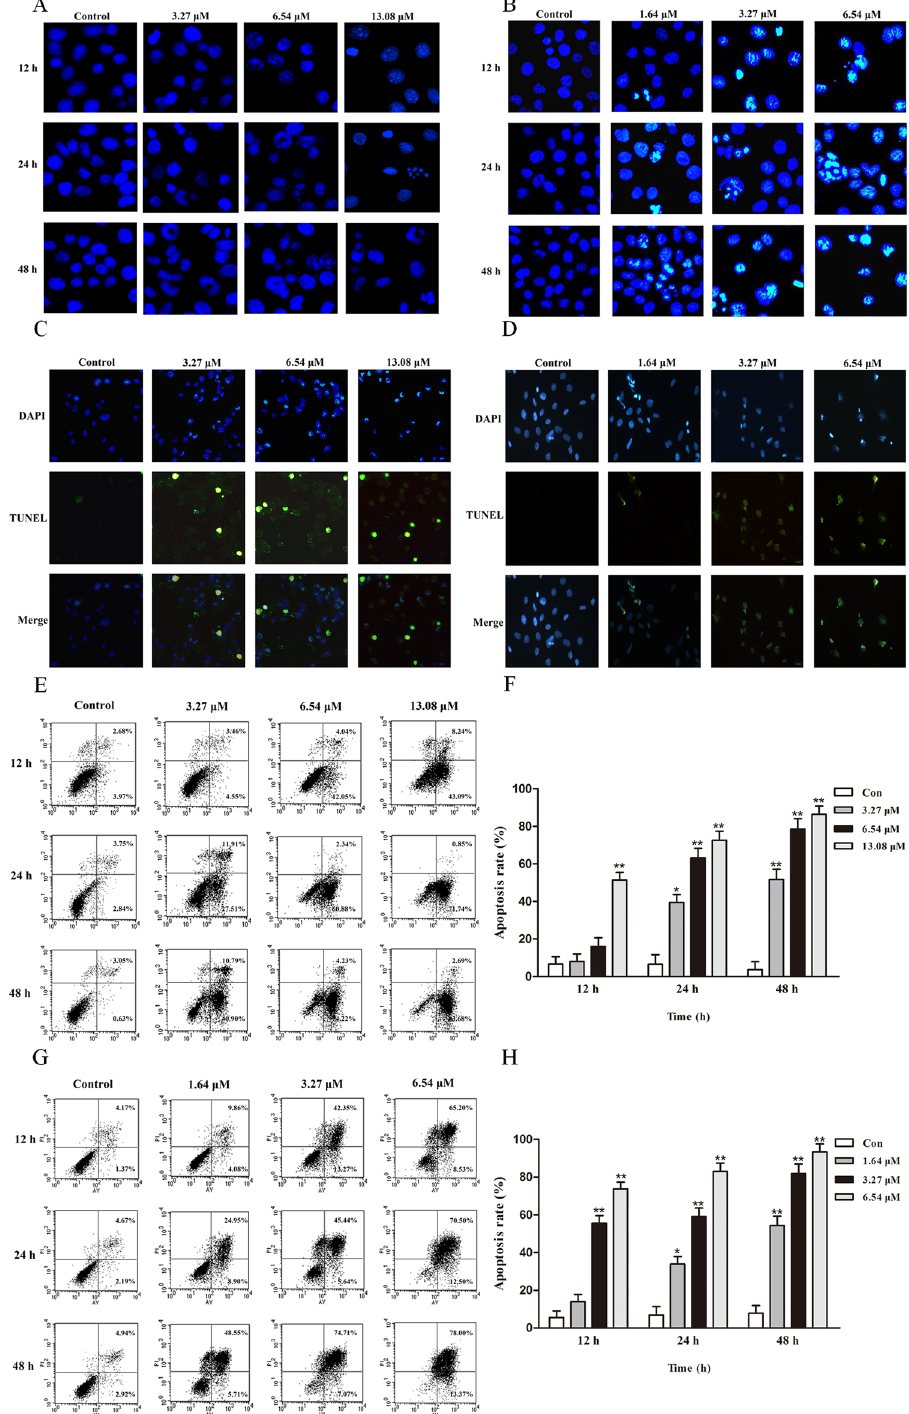
Figure 4. DNA segmentation of HeLa ( A ) and CaSki ( B ) cells detected by DAPI stain. TUNEL-assay for detection of apoptosis in HeLa ( C ) and CaSki ( D ) cells. ( E , F ) Apoptosis of HeLa cells detected by the Annexin V-FITC/PI staining test and the ratio of apoptosis cells. The data represented the means ± SD for triplicate determinations. * P < 0.05, ** P < 0.01 versus control cells. ( G , H ) Apoptosis of CaSki cells detected by the Annexin V-FITC/PI staining test and the ratio of apoptosis cells, including early apoptotic cells (lower right quadrant) and late apoptotic cells (upper right quadrant). The data represented the means ± SD for triplicate determinations. * P < 0.05, ** P < 0.01 versus control